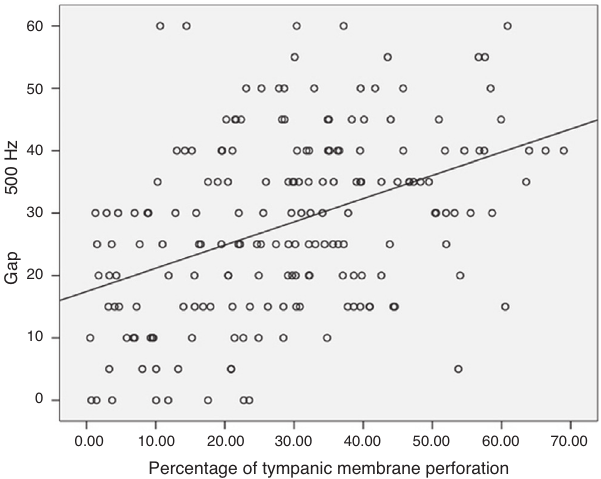
Figure 3 Correlation between the percentage of tympanic membrane perforation and air-bone gap observed at a 1000 Hz frequency.